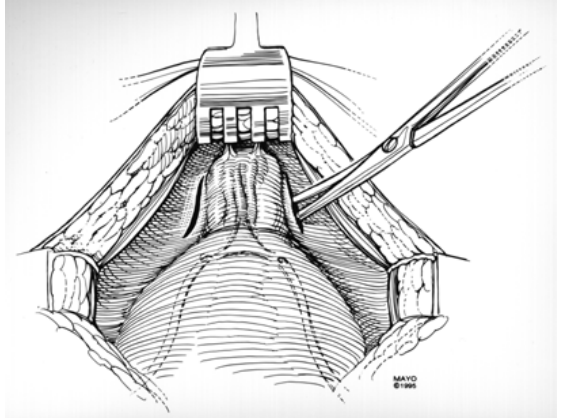
FIGURE 8. Dissection around the bladder neck.